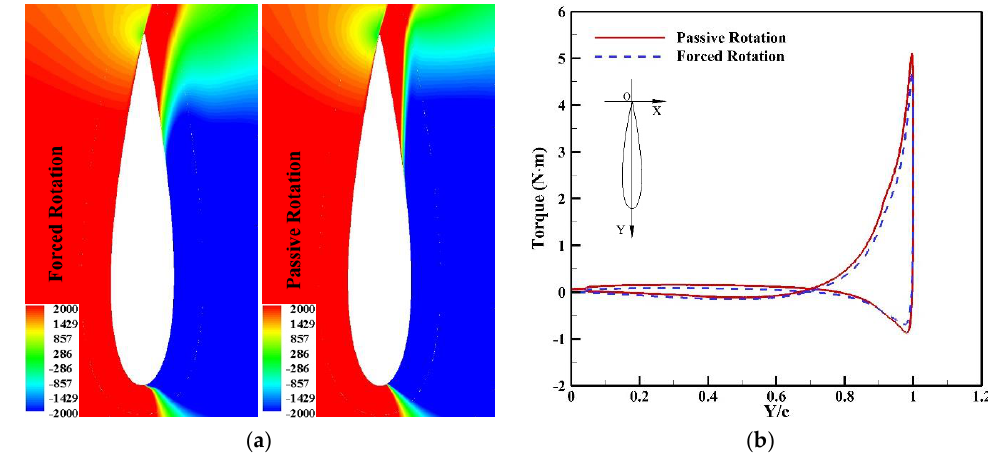
Figure 11. Comparison of hydrodynamics between the forced and passive rotations: ( a ) Pressure Contour; ( b ) Hysteresis loop of torques.